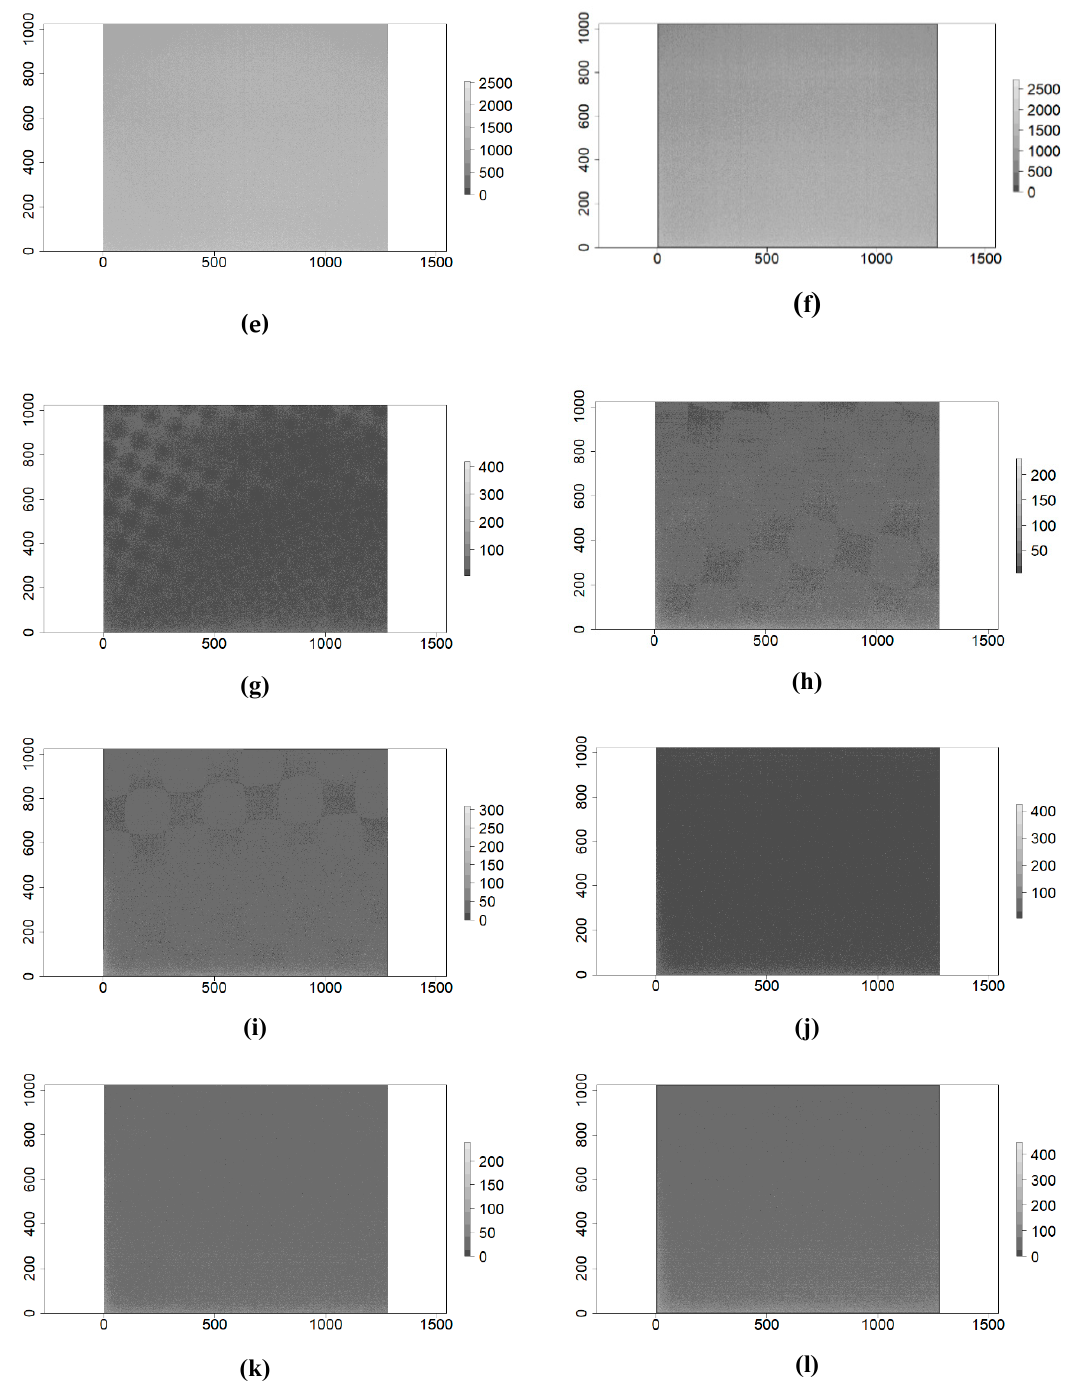
Figure 10. Dark offset imagery taken at a temperature 8 °C, exposure time 500 μ S of all bands: ( a ) Average image B1; ( b ) Average image B2; ( c ) Average image B3; ( d ) Average image B4; ( e ) Average image B5; ( f ) Average image B6; ( g ) Standard deviation image B1; ( h ) Standard deviation image B2; ( i ) Standard deviation image B3; ( j ) Standard deviation image B4; ( k ) Standard deviation image B5; ( l ) Standard deviation image B6. The average and standard deviation (SD) images are calculated from 20 samples.